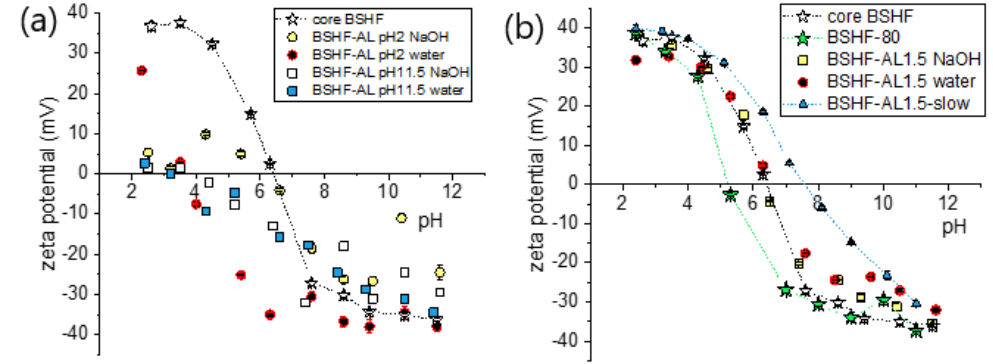
Figure 7. Zeta potential vs pH: ( a ) core BSHF and BSHF-AL NPLs prepared at different pH and washed with NaOH solution or water; ( b ) BSHF-AL-1.5 (pH = 2, washed with water) compared with the core BSHF NPLs that underwent the same treatment. Lines in the panels serve only as a guide for the eye.